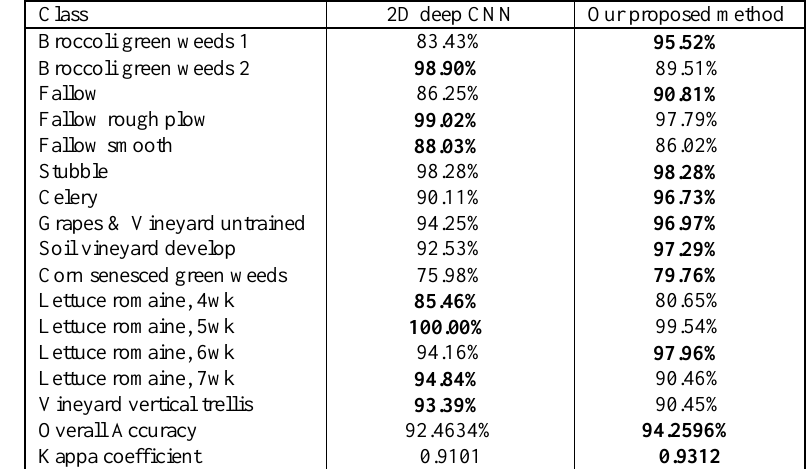
Table 2. Overall accuracies, individual classification accuracies and kappa coefficient obtained for different classification methods when applied to the AVIRIS Salinas scene hyperspectral data